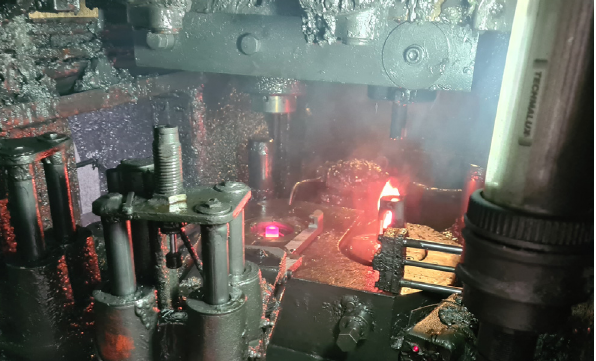
Figure 2. Photo of a press chamber in an industrial forging process with visible lubricant residues and a flame due to oil burnout after contact with a hot forging in the die.